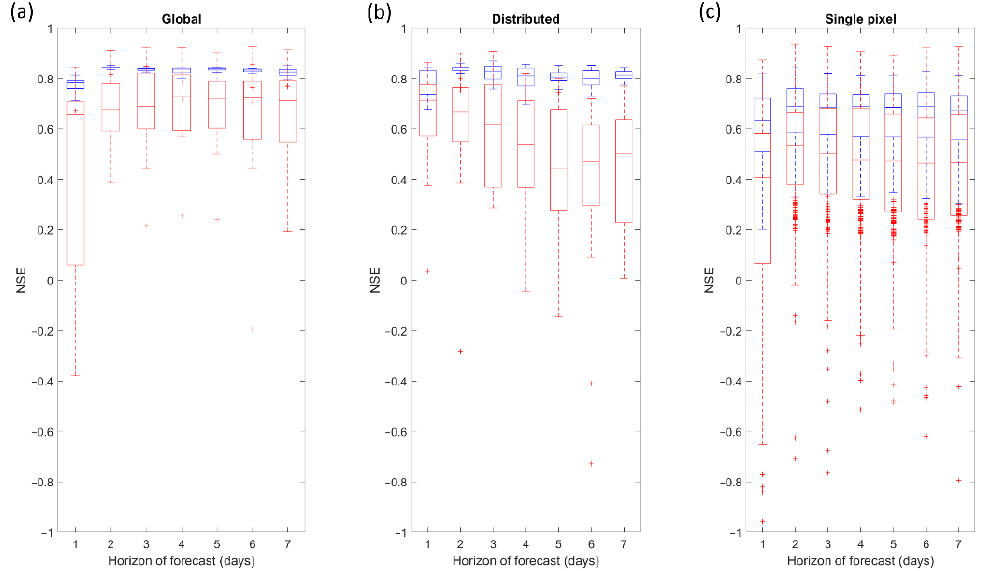
Figure 13. For the Androscoggin watershed, the evolution of the NSE across the 7-day forecast window for 3 types of input spatialization: ( a ) global (i.e., grid average), ( b ) distributed (i.e., full-grid), and ( c ) single pixel (i.e., each of the 28 grid points individually). Each boxplot represents the dispersion across the 16 years used in cross-validation, blue is training, red is validation.